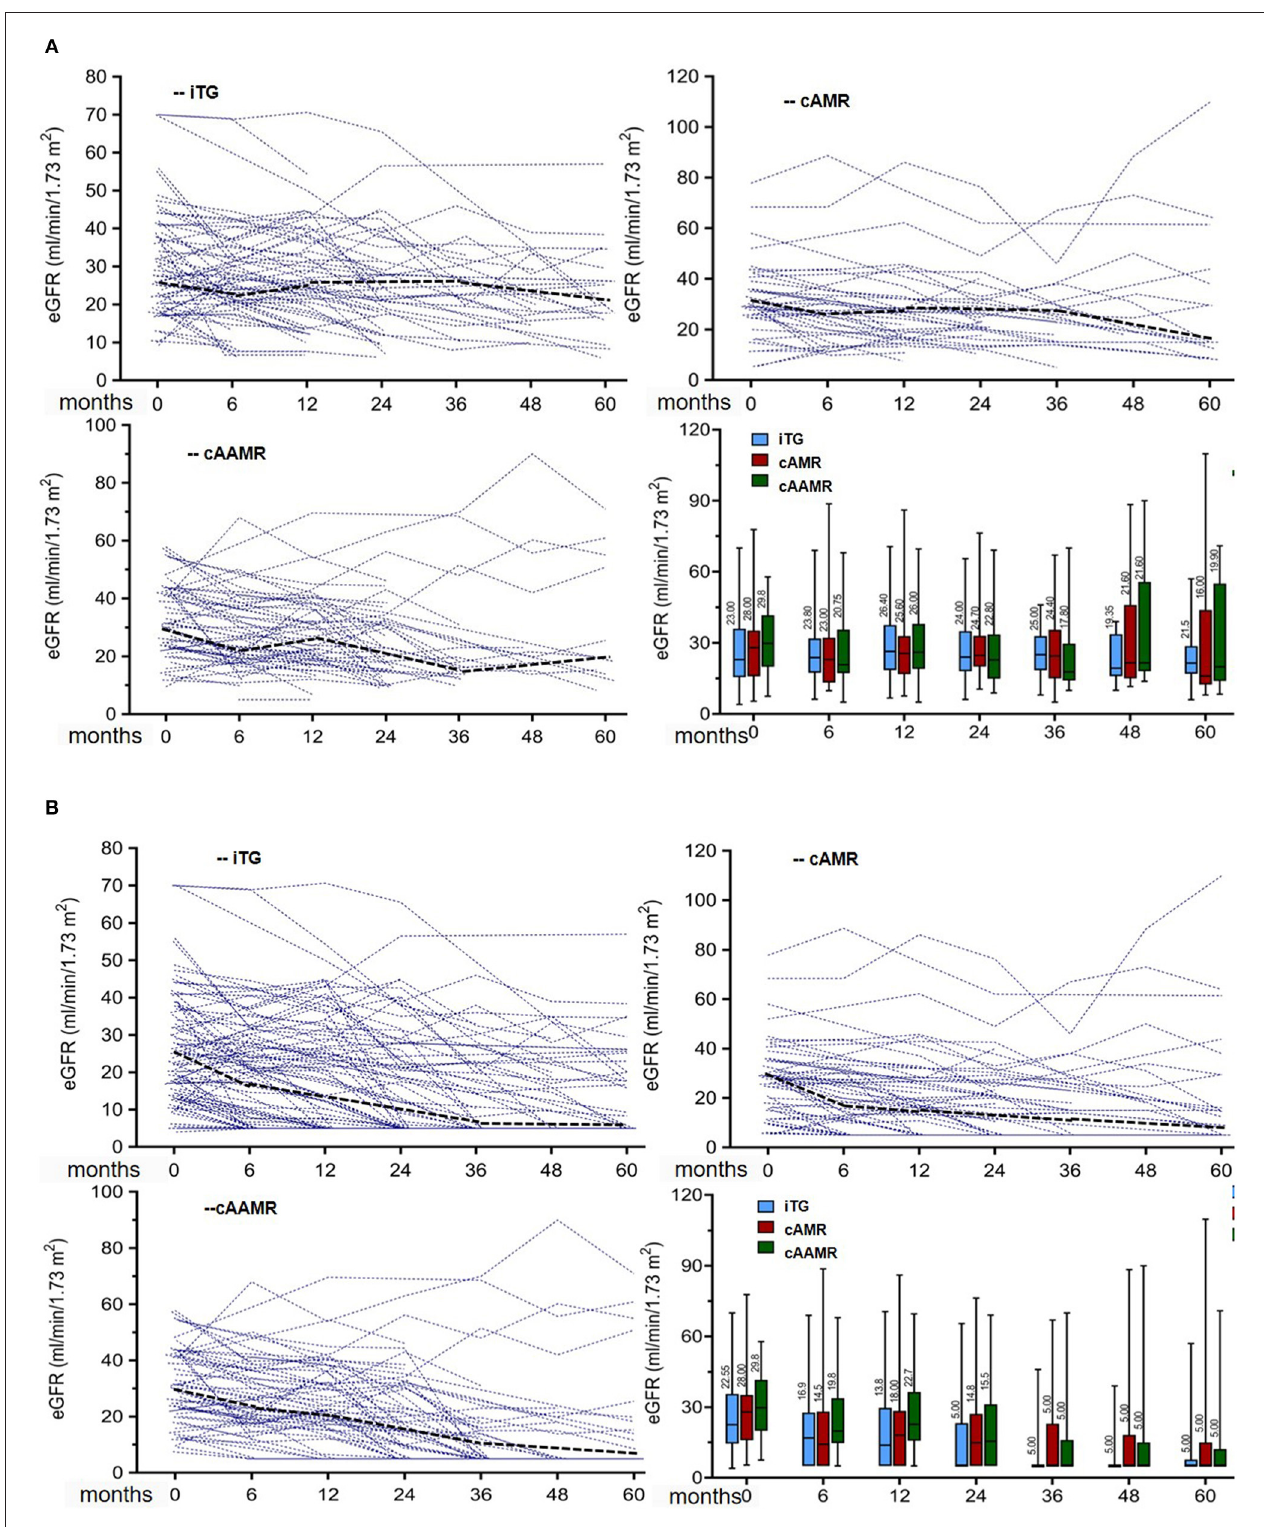
FIGURE 2 | (A) Effects of TG categories on the evolution of eGFR, for patient death or return to dialysis, no data of eGFR were imputed. (B) Effects of TG categories on the evolution of eGFR, for patient return to dialysis, eGFR were imputed as 5 ml/min/1.73 m 2. Individual eGFR course (thin dashed lines) and median eGFR (fat dashed lines) in relation to TG categories. Analyses are on the basis of serial eGFR measurements at 0, 6, 12, 18, 24, 36, 48, and 60 months. Box plots indicate the median, the interquartile range, the minimum, and the maximum of the measures.